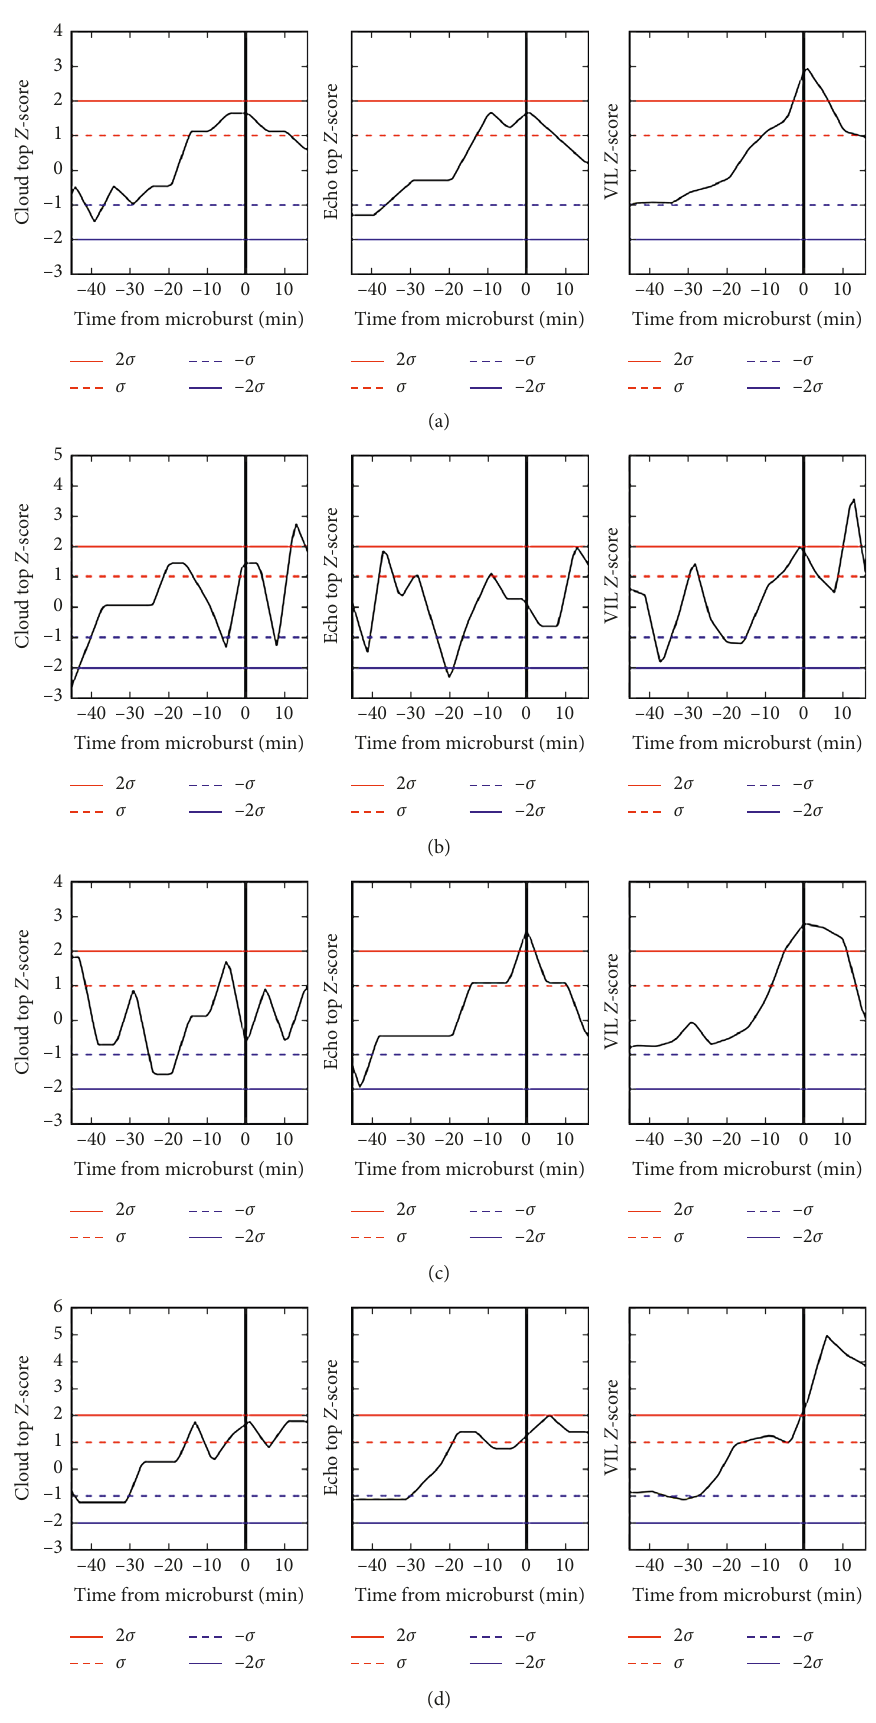
Figure 14: Radar parameters—cloud top, echo top, and VIL—for the first four severe wind cases. (a) 20120724 null. (b) 20130624 null. (c) 20140703 null. (d) 20150612